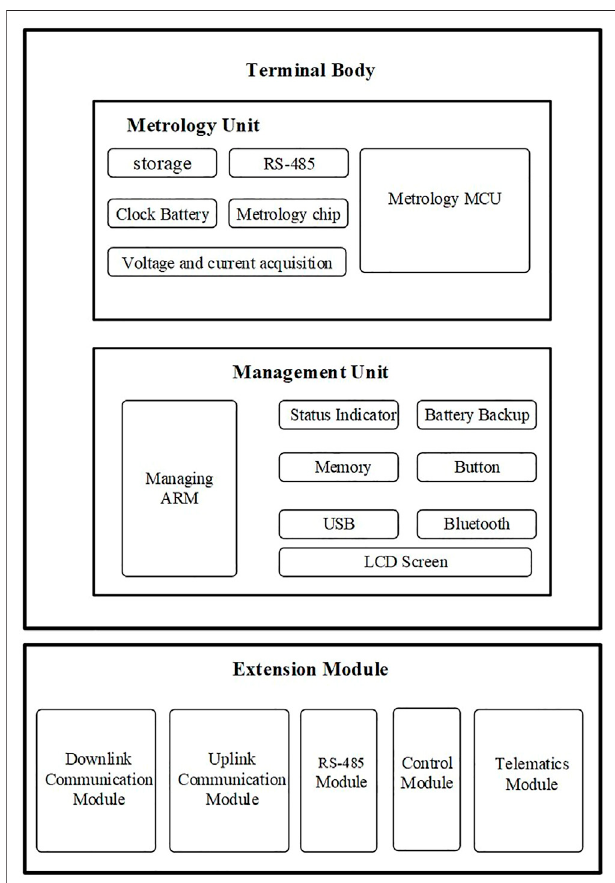
FIGURE 1 | Hardware structure of an intelligent perception